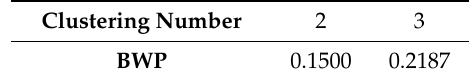
Table 5. BWP index of Z 11 , Z 12 , Z 112 and Z 31 with different number of clusters.